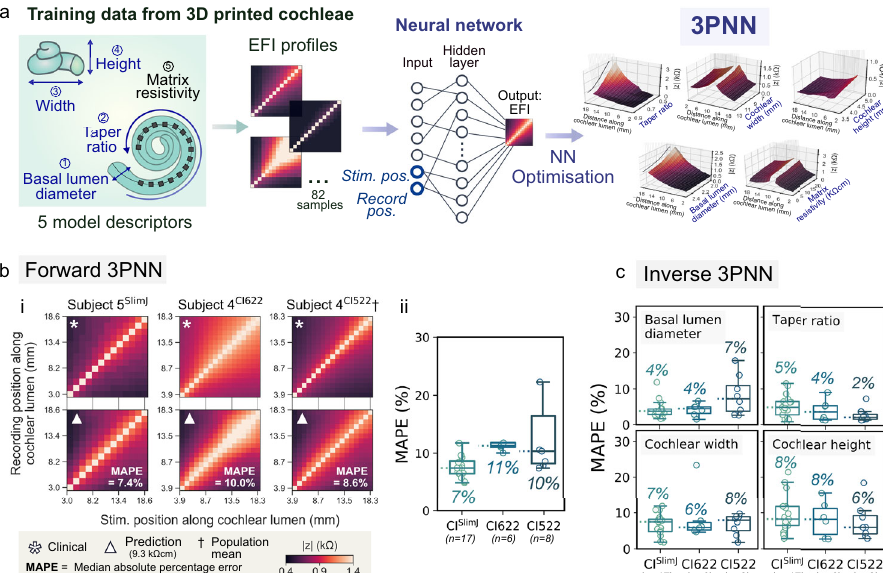
Fig. 5 Clinical validation of 3PNN. a Schematic of the work fl ow of 3PNN. 3PNN was developed by training a neural network machine learning algorithm with the EFI pro fi les acquired from the 3D printed biomimetic cochleae. 3PNN maps the correlation between the fi ve model descriptors and the most probable EFI pro fi le as a function of CI electrode position. The hyperparameters of 3PNN were tuned using tenfold cross-validation to achieve the best predictive performance (Supplementary Fig. 9). b Validation of forward-3PNN for predicting patient off-stimulation EFIs (matrix resistivity input = 9.3 k Ω cm). (i) Representative off-stimulation EFI predictions for different CI electrode types, as compared to the corresponding clinical patient data; and (ii) boxplots summarising the overall performance of forward-3PNN, with the median MAPE of each CI electrode type indicated on the fi gure. Full validation results can be found in Supplementary Fig. 11. c Overall performance of inverse-3PNN for inferring the patients ’ cochlear geometric descriptors for different CI electrode types, with the median MAPE stated for each descriptor. Full validation results of inverse-3PNN can be found in Supplementary Fig. 13. In b (ii) and c the line in each box represents the median, with the box denoting the interquartile range and the whiskers denoting the ±1.5 of the interquartile